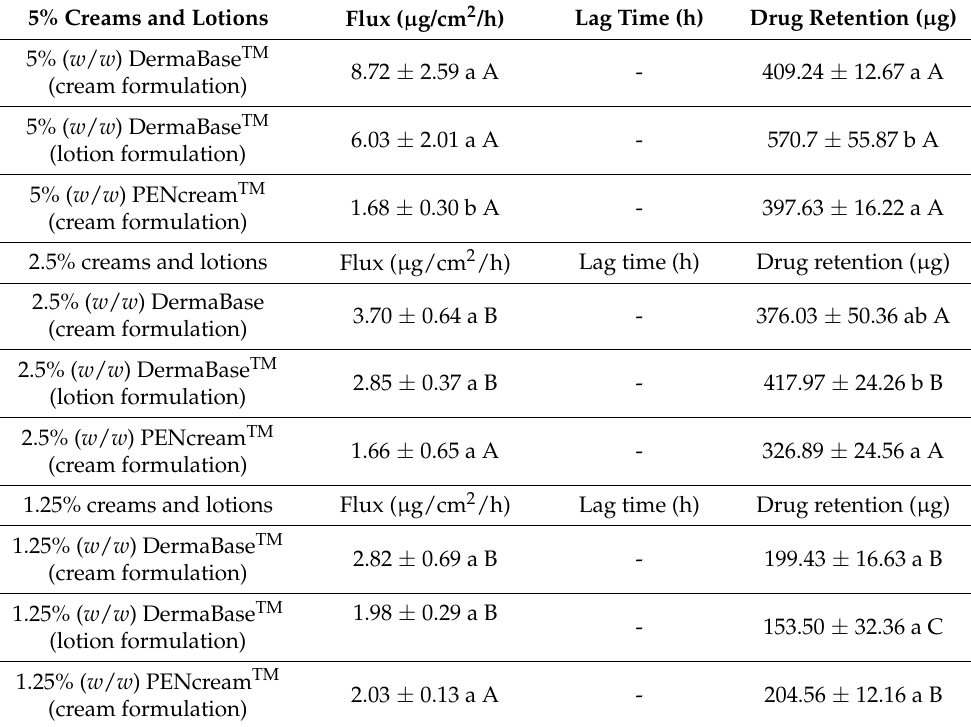
Table 2. In vitro drug membrane parameters of resatorvid topical creams and lotion formulations through Strat-M ® transdermal diffusion membrane ( n = 3, mean ± standard deviation). Lowercase letters indicate differences between formulations with the same concentration. Capital letters indicate difference between concentrations in the same formulation ( p < 0.05).